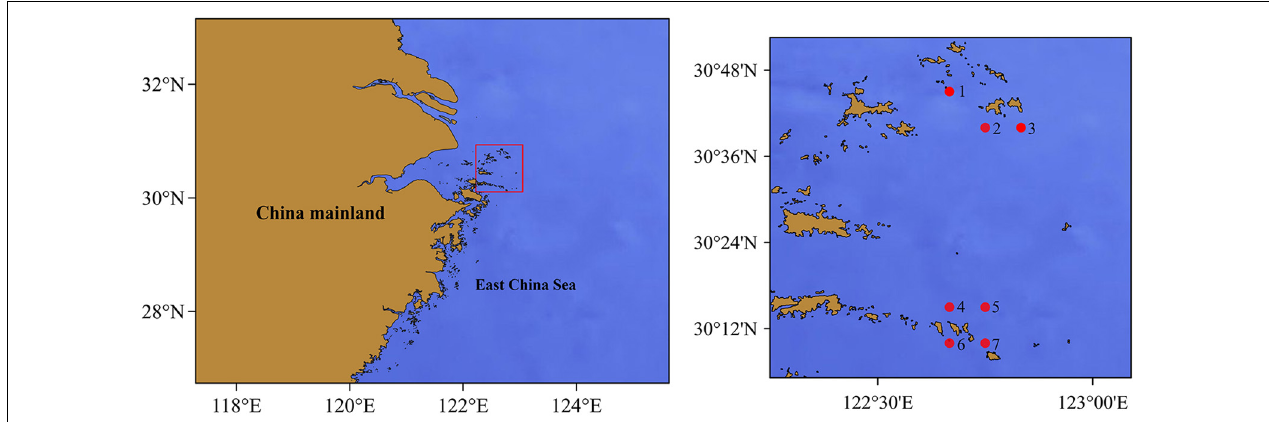
FIGURE 1 | Location of samples collected in the Zhoushan Sea (China). Seawater samples for eDNA analysis and catches for biological identification (the dots represent the coastal water sampling sites and the end position of the bottom trawl).